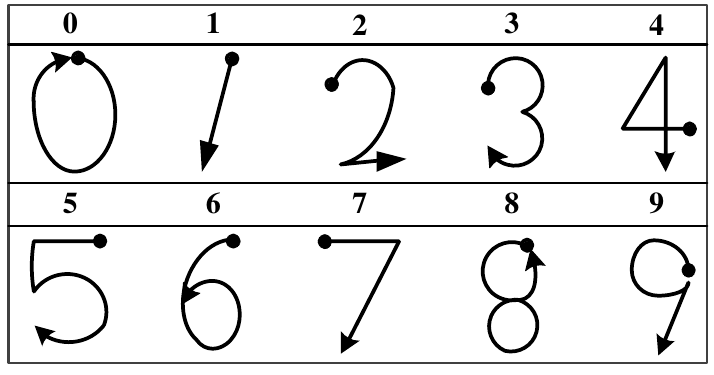
Figure 10. 3D number dataset.